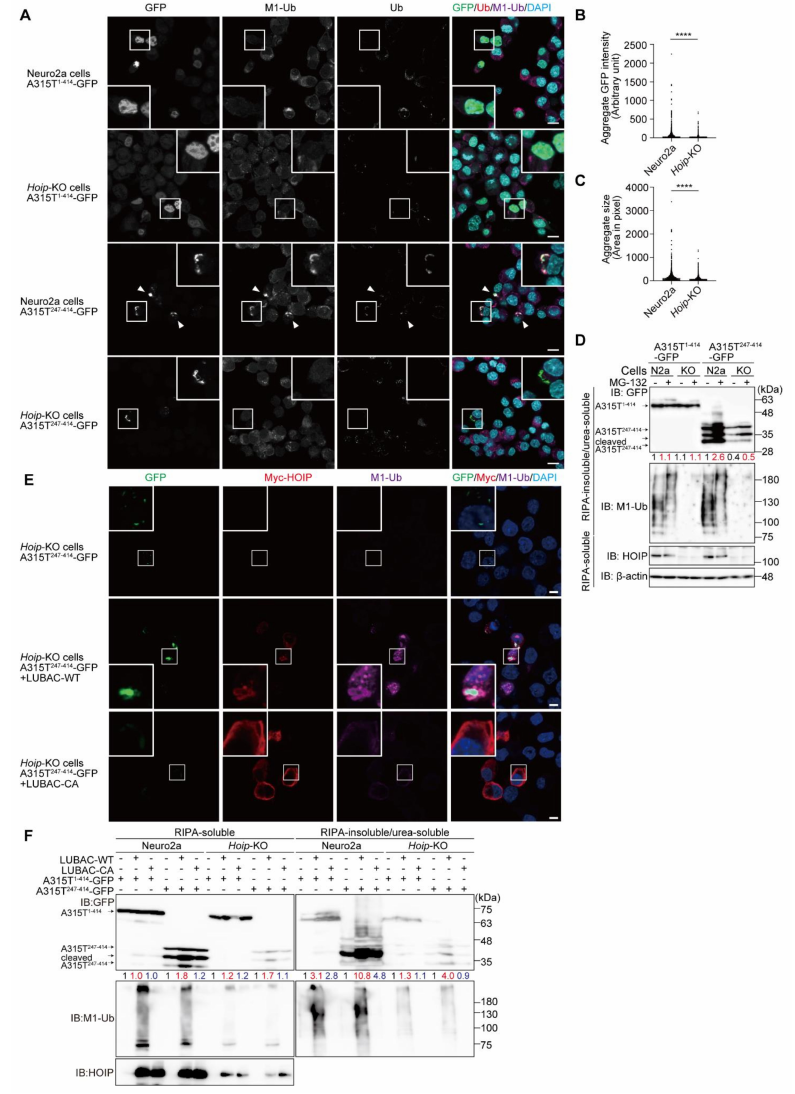
Figure 4. LUBAC-mediated linear ubiquitination activity is involved in cytoplasmic aggregation of the TDP-43 mutant. ( A ) Genetic ablation of Hoip reduces the cytoplasmic aggregation of